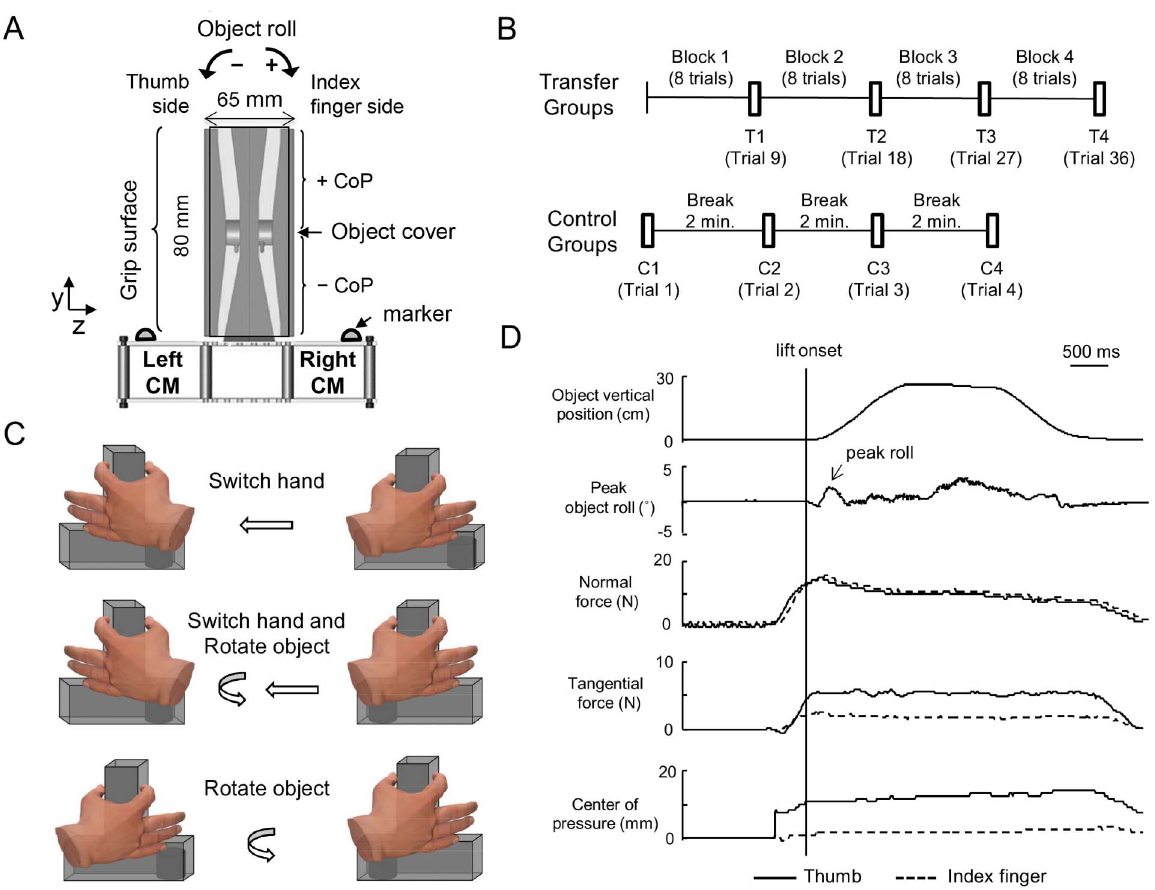
Figure 1. Experimental setup and procedures. Panel A shows the custom-built inverted-T grip device used to measure forces and centers of pressure of the thumb and index finger. Note that ‘thumb side’ and ‘index finger side’ denote a grasp performed with the right hand. Two light- emitting diode markers were mounted on the base of the device to track object kinematics (vertical position and roll in the x-y plane). A 400 g mass was inserted in either the left or right compartment to change the center of mass (CM) of the object to create an external moment. A cover was taped on the front and back of the grip device to block view of force/torque sensors. Panel B shows the trial sequence for the transfer groups (upper) and the control groups (lower). Panel C shows three learning transfer conditions with ‘‘switch hand’’ and/or ‘‘object rotation’’. The example shown denotes a subset of the experimental conditions, i.e., one CM condition per transfer action. Panel D shows data from one representative subject (S9) and the experimental variables: object vertical position, peak object roll, normal and tangential forces of thumb and index finger, and center of pressure for each digit. The sign convention for the digit center of pressure is shown in panel A. Note that the data are from the last trial of Block 1 performed with a left CM object lifted by the right hand. At this stage of the trial sequence, this subject learned to generate a compensatory moment to minimize object roll ( , 3 u ). Note that this subject exerted a larger tangential force with the thumb (the added mass was on the thumb side) and the thumb center of pressure was higher than the index